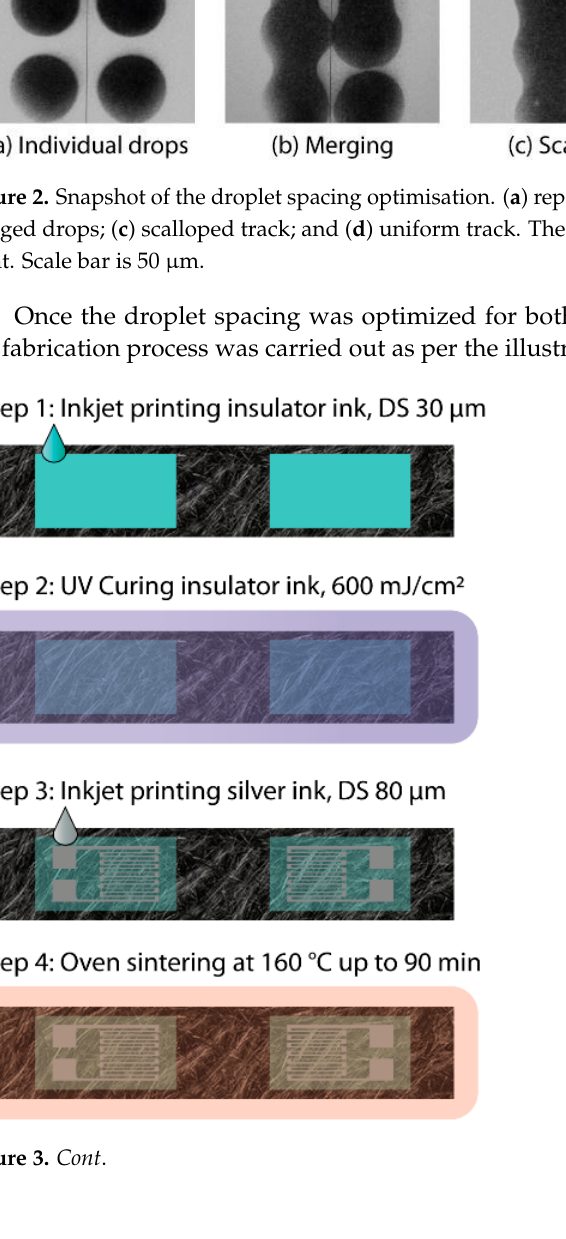
Figure 3. Illustration of the process steps using inkjet printing to integrate the strain sensor into the carbon fibre composite.